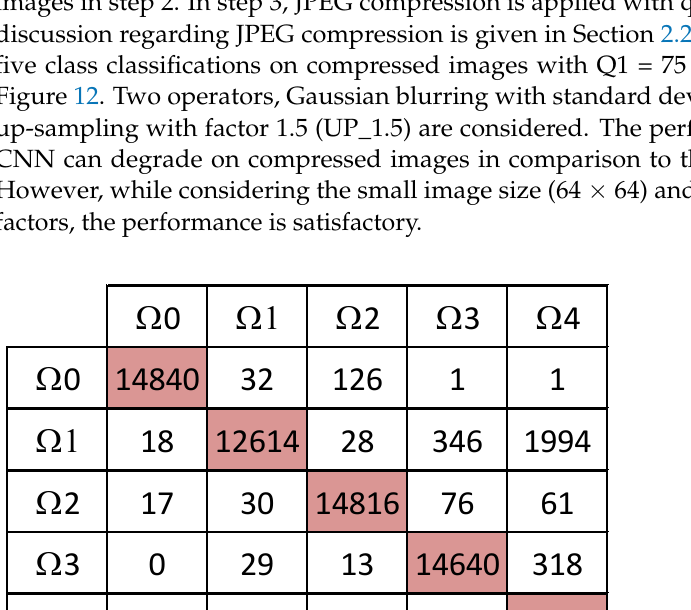
Figure 12. Confusion matrix of GAU_1.0 and UP_1.5 operator sequence with Q1 = 75, Q2 = 85.